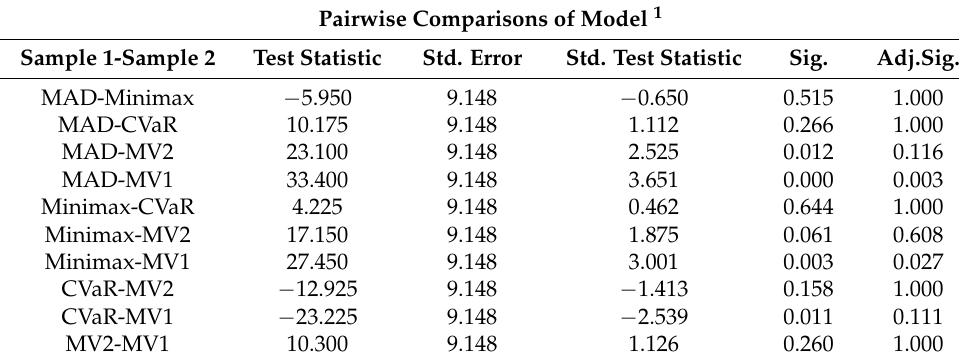
Table A2. Results of pairwise comparisons of model for Sharpe ratio ranking.